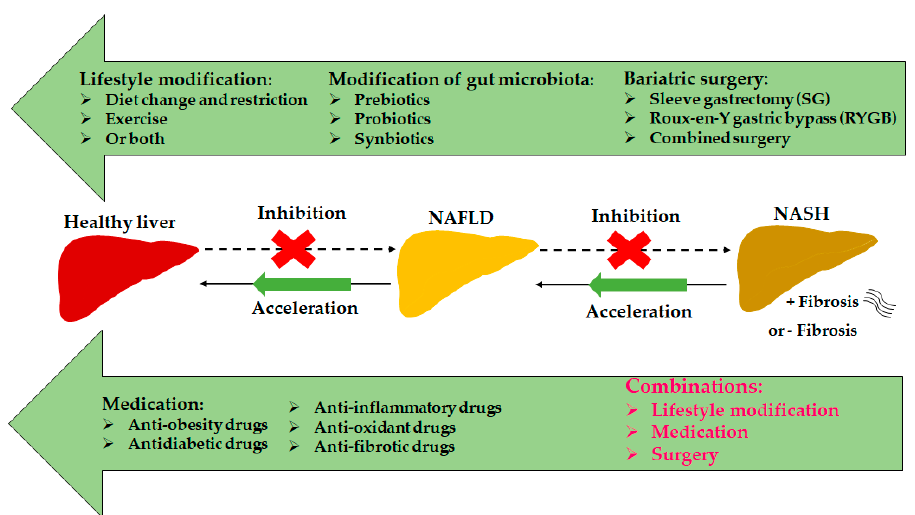
Figure 2. Treatment options for NAFLD or NASH. The currently effective treatment options for NAFLD/NASH include lifestyle modification, bariatric surgery, and medicines. In addition, modification of gut microbiota by prebiotics, probiotics, or synbiotics shows promising effects.